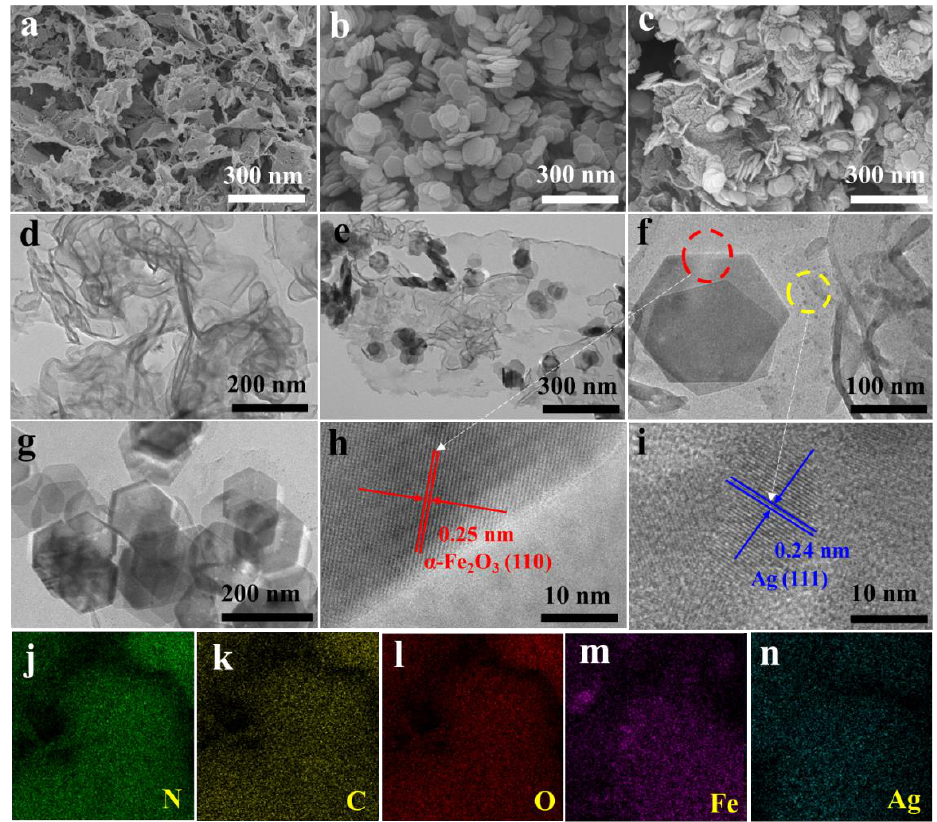
Figure 3. ( a ) SEM image of ( a ) g-C 3 N 4 , ( b ) α -Fe 2 O 3 and ( c ) α -Fe 2 O 3 /g-C 3 N 4 , TEM image of ( d ) g-C 3 N 4 , ( e ) α -Fe 2 O 3 /g-C 3 N 4 , ( f ) Ag/α -Fe 2 O 3 /g-C 3 N 4 , ( g ) α -Fe 2 O 3 , HRTEM image of ( h ) α -Fe 2 O 3 and ( i ) Ag na- noparticles, ( j – n ) SEM- EDX mapping of Ag/α -Fe 2 O 3 /g-C 3 N 4 .